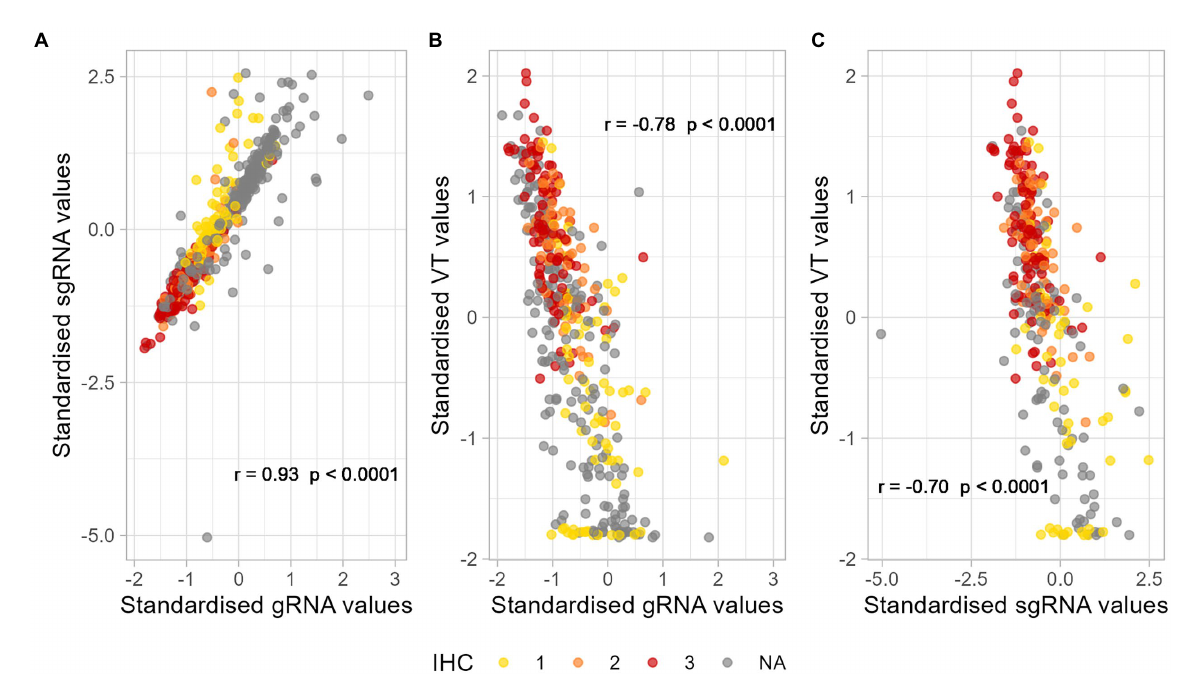
FIGURE 1 Correlation between the standardised results of positive samples by (A) sgRNA and gRNA RT-qPCR, (B) VT and gRNA RT-qPCR, and (C) VT and sgRNA RT-qPCR. Different colours represent semiquantitative IHC scores assigned to positive samples. p -Values lower than 0.05 are considered significant. (A) r = 0.93, p -value < 0.0001. (B) r = − 0.78, p -value < 0.0001. (C) r = − 0.70, p -value < 0.0001. r , Spearman’s correlation coefficient; RT-qPCR, reverse transcription followed by quantitative polymerase chain reaction; gRNA, genomic RNA; sgRNA, subgenomic RNA; IHC, immune histochemistry; VT, infectious viral titration. NA,